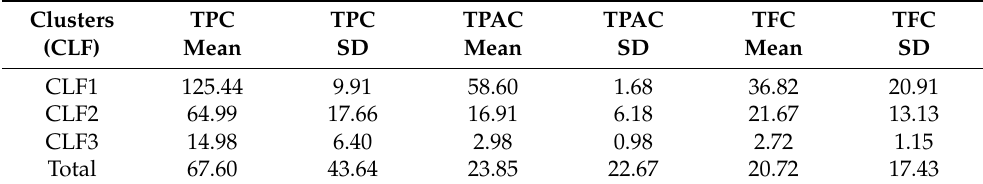
Table 8. Belonging to clusters (CLF) n = 8 of phytochemicals content.